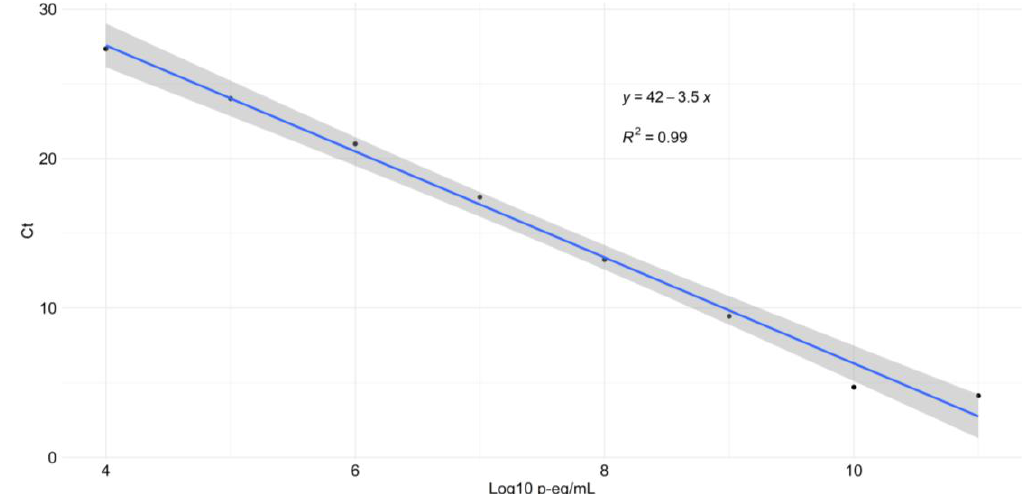
Figure 2. Linear regression plot of the standard curve. X -axis values for equivalent parasites were transformed to Log10 scale.